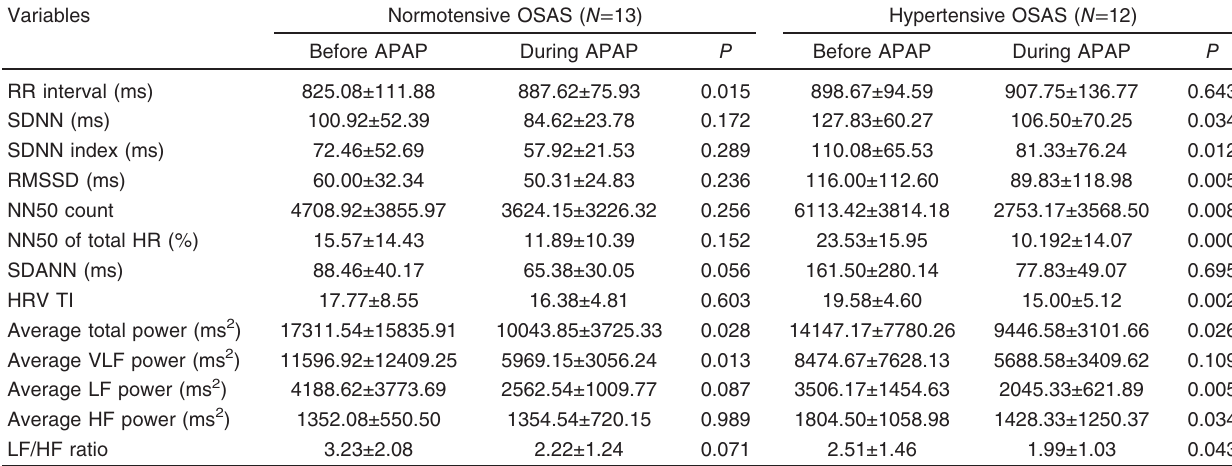
Table 2 Heart rate variability before and during automatic positive airway pressure in normotensive and hypertensive obstructive sleep apnea syndrome patients Variables